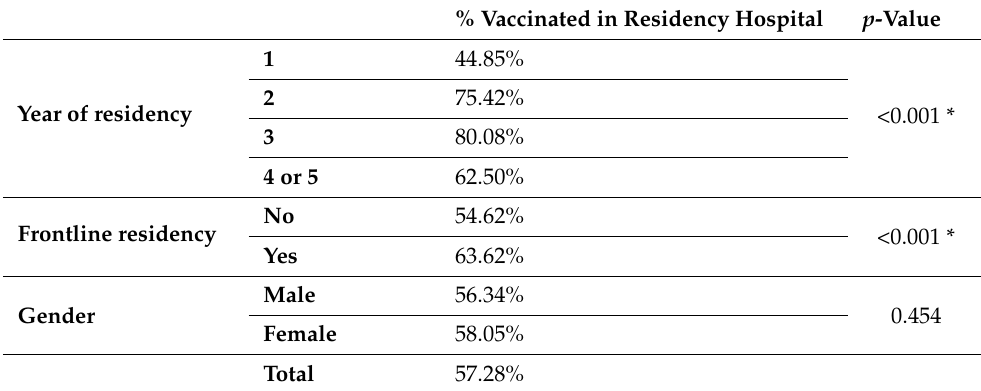
Table 2. Univariate analyses were performed using the Chi-Square test, with vaccination in resi- dency hospital as the outcome and year of residency, frontline residency, and gender as covariables (* p < 0.05, statistically significant).